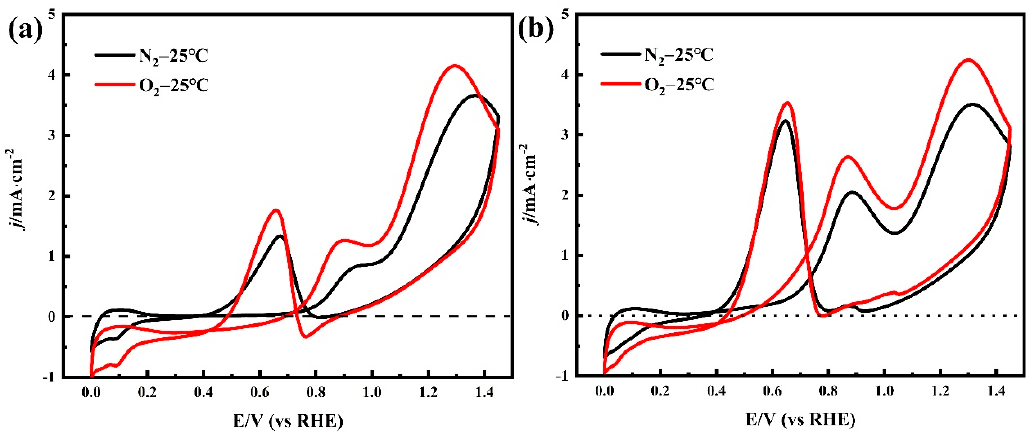
Figure 4. ( a ) Cyclic voltammograms recorded with a Pt/C electrode in 0.05 M H 2 SO 4 + 0.1 M NPA